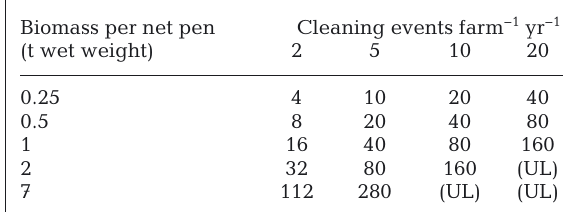
Table 1. Potential emissions (tonnes) of biofouling ‘cleaning waste’ for an average Norwegian salmon farm comprising 8 production pens (50 m diameter). Emitted biomass is a func- tion of the amount of growth on individual nets and the fre- quency at which the nets are cleaned. Biofouling intensity varies regionally, but up to 7 t of biofouling have been re- ported for individual pen nets (Bloecher 2013). Extreme foul- ing biomass is unlikely to accumulate in situations where cleaning occurs at short intervals; some combinations of foul- ing biomass and cleaning frequency are thus considered un- likely (UL). Note that the data presented here are for illustra- tive purposes and do not represent definite values of